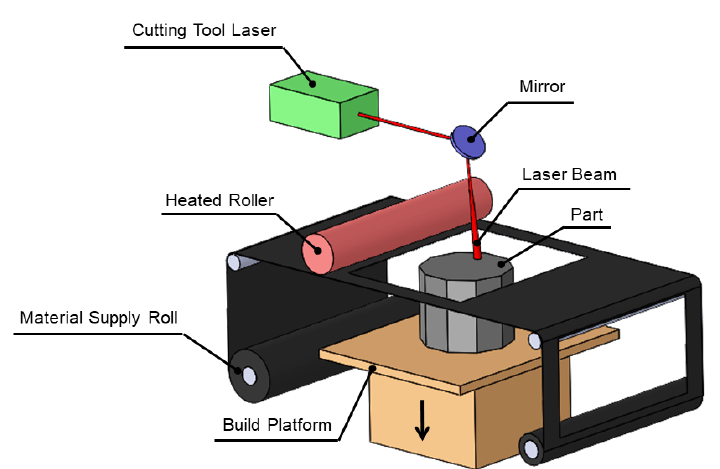
Figure 5. Laminated Object Manufacturing